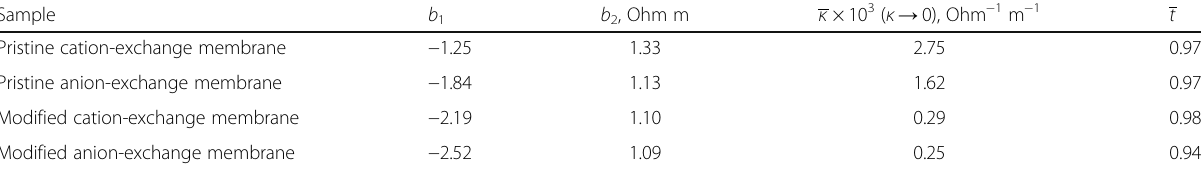
Table 1 Parameters for characterization of electrical conductivity and charge selectivity of the membranes Sample